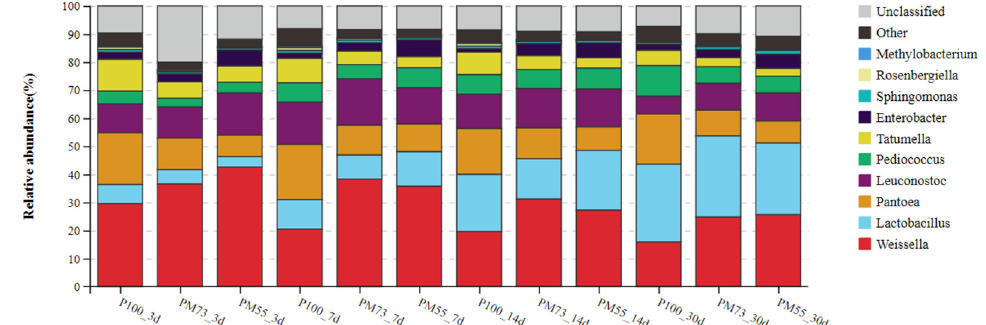
Figure 2. Bacterial community and relative abundance by genus for mulberry leaf silages (P100, 100% hybrid Pennisetum silage; PM73, hybrid Pennisetum and mulberry leaves mix-silage in a ratio of 7:3; PM55, hybrid Pennisetum and mulberry leaves mix-silage in a ratio of 1:1; 3d, 3 days of ensiling; 7d, 7 days of ensiling; 14d, 14 days of ensiling; 30d, 30 days of ensiling).